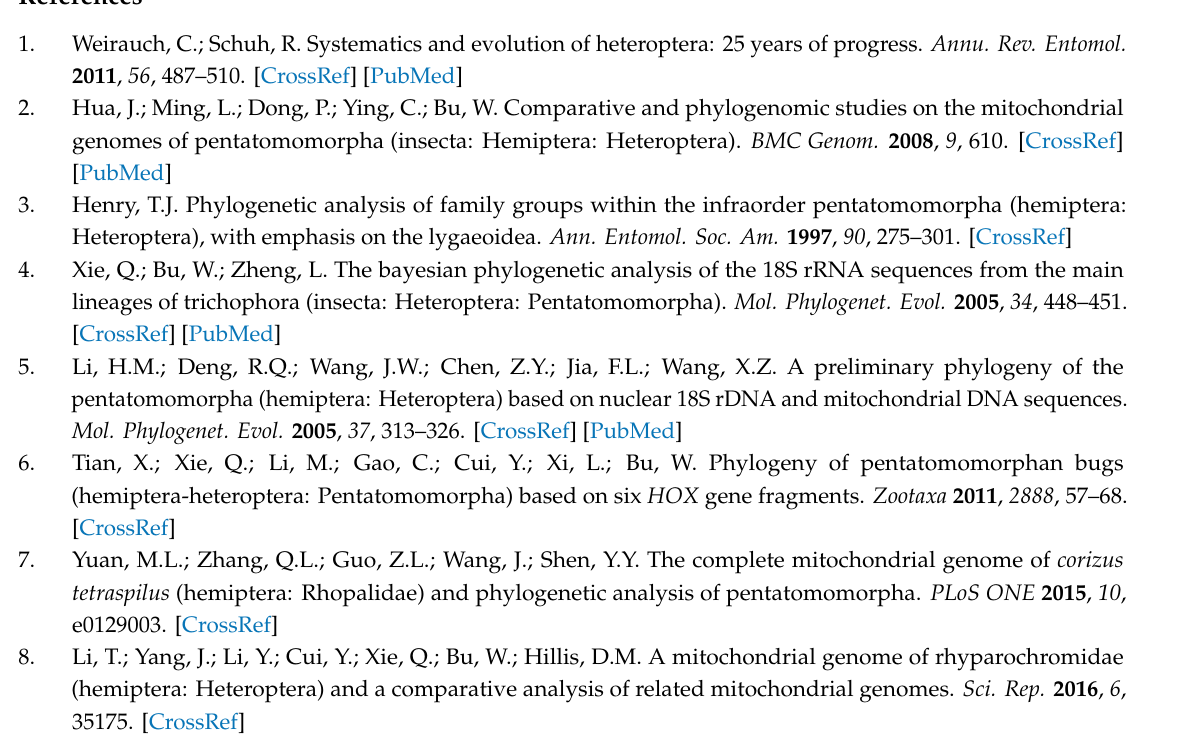
PCGs. Figure S8: RAxML phylogenetic relationships among five Pentatomomorpha super-families. Phylogenetic analysis is based on the concatenated amino acid sequences of 13 mitochondrial PCGs. Figure S9: PhyloBayes concatenated amino acid sequences of 13 mitochondrial